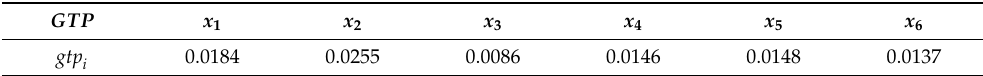
Table 10. Group totality preference value.